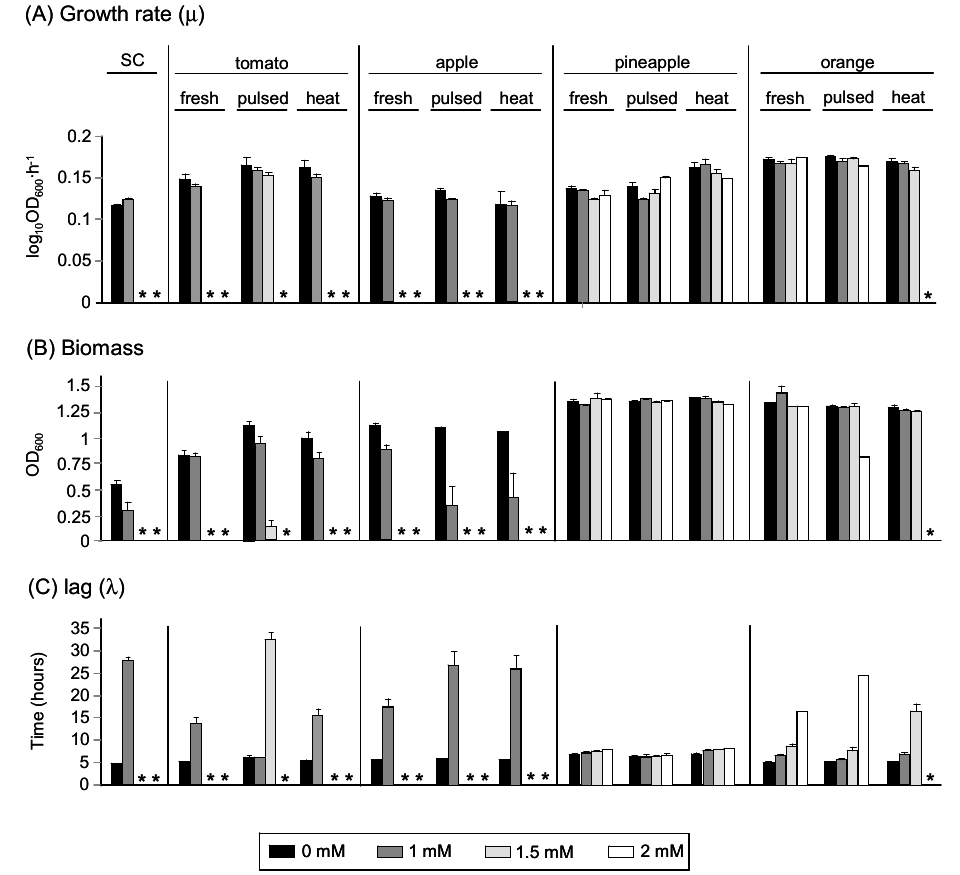
Figure 1. Effect of t − BOOH on the growth of Plus Vital baker’s yeast cells in juices. Cells were grown in synthetic SC medium as well as in tomato, apple, pineapple and orange juices untreated (fresh) or previously treated with a pulsed electric field or heat for 30 h at 30 ◦ C in the presence of the different concentrations of t − BOOH (0, 1, 1.5, 2 mM). OD 600 was automatically recorded at 1 h intervals. Curves correspond to a representative experiment in which cultures in the same medium with increasing oxidant concentrations were grown in parallel. Mean values of µ ( A ), final biomass ( B ) and λ ( C ) from at least three independent experiments of cultures (mean ± standard deviation) were calculated from the corresponding curves. * no